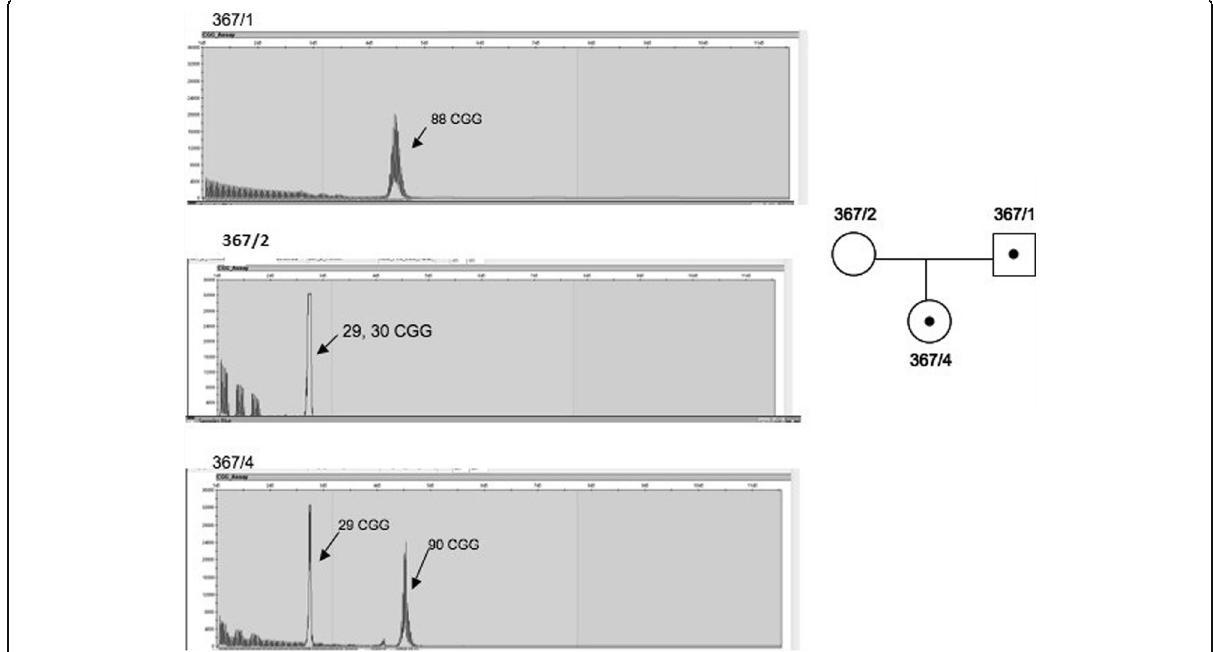
Fig. 1 Paternal premutation allele inheritance (PIP) with low expansion (CGG repeat expansion 88 90). The figure shows the examination of the family No.10 (code 367). The patient inherited the normal 29 CGG repeat number allele from the mother. The other allele was inherited from the father, where the paternal 88 CGG repeat number expanded to 90 was observed in the patient. There was no evidence of AGG interruptions in the father. The two AGG interruptions are in accordance with the maternal allele